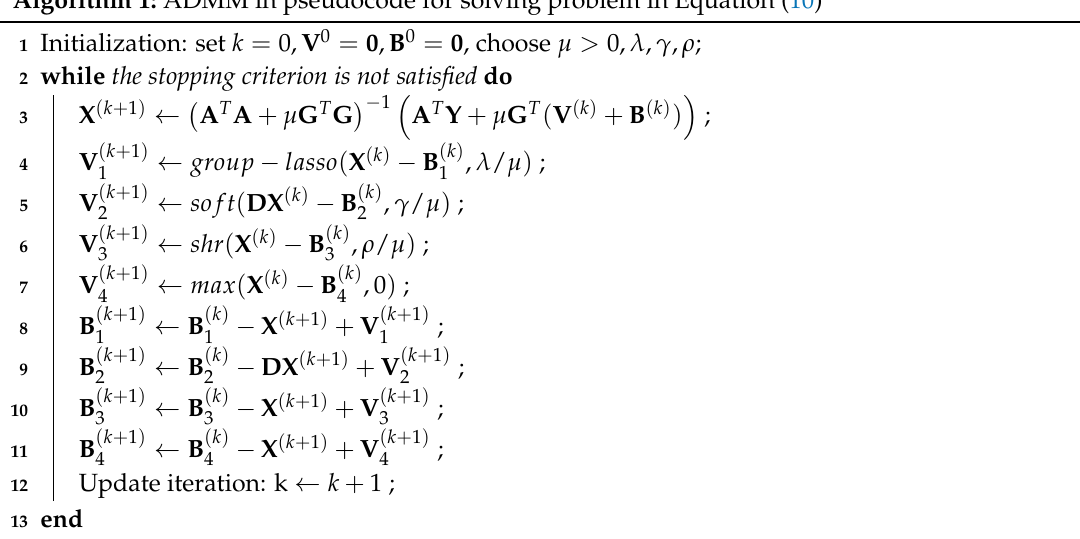
Algorithm 1: ADMM in pseudocode for solving problem in Equation